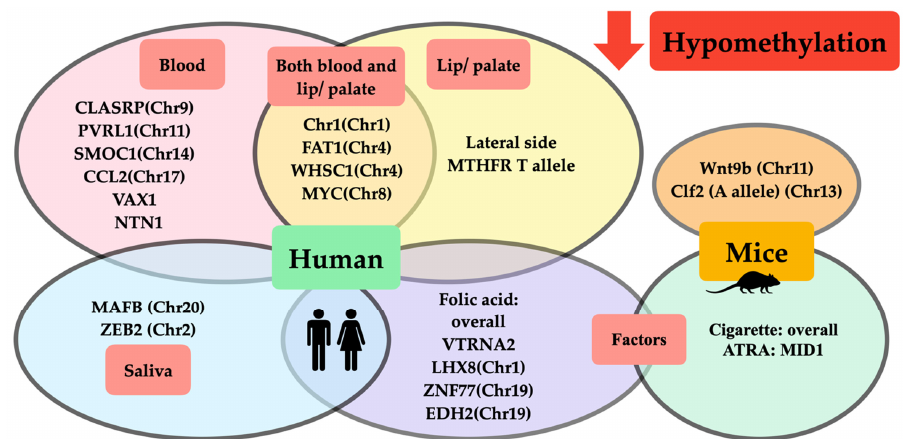
Figure 1. Schematic representation of DNA hypomethylation in orofacial clefts from animal and clinical studies. Hypomethylation from clinical studies demonstrated that (1) hypomethylated genes and chromosomes in human blood (pink circle) were CLASRP(Chr9), PVRL1 (Chr11), SMOC1(Chr11), CCL2(Chr17), VAX1, and NTN1; (2) hypomethylated genes and chromosomes in lip/ palatal tissue (yellow circle) were lateral side of lip tissue, MTHFR T allele; (3) hypomethylated genes and chromosomes found either in blood or lip/palatal tissue (intersection area between pink and yellow circle) were Chr1(Chr1), FAT1(Chr4), WHSC1(Chr4), and MYC(Chr8); (4) hypomethyl- ated genes and chromosomes in saliva (blue circle) were MAFB(Chr20) and ZEB2(Chr2); and (5) factors affecting DNA hypomethylation in clinical studies (purple circle) included folic acid affecting hypomethylation of overall methylation of VTRNA2, LHX8(Chr1), ZNF77(Chr19), and EDH2(Chr19). Hypomethylation from animal studies demonstrated that (1) hypomethylated genes and chromosomes in mice (orange circle) were Wnt9b(Chr11) and Clf2(A allele)(Chr13); and (2) factors affecting DNA hypomethyla- tion in studies on mice (green circle) included cigarettes affecting hypomethylation of overall DNA methylation and ATRA affecting hypomethylation of MID1.